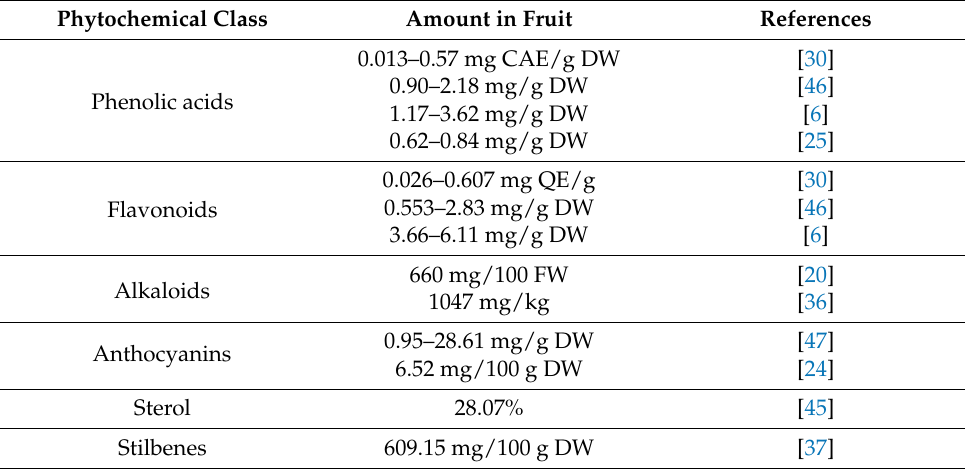
Table 4. Major phytochemical classes of M. alba